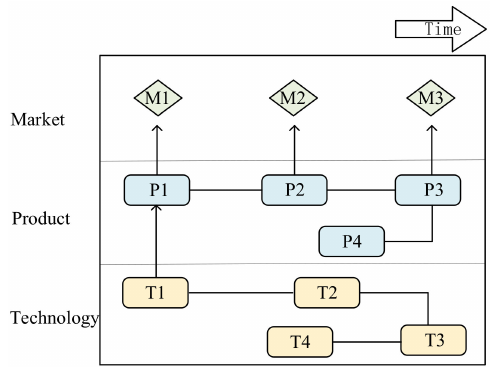
Figure 1. Structure of technology